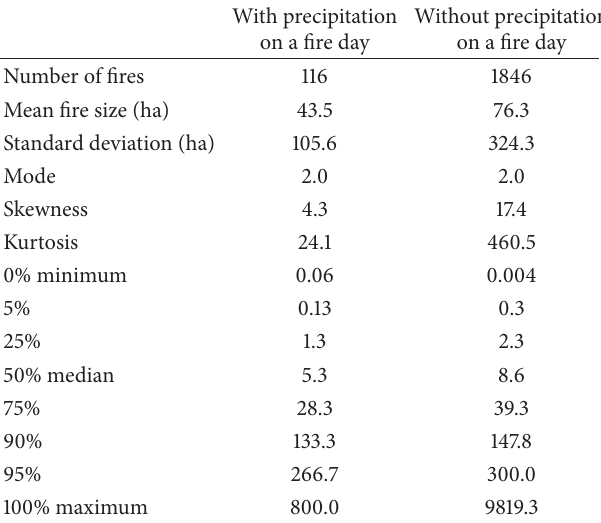
Table 2: Summary statistics of burned areas of forest fires with and without